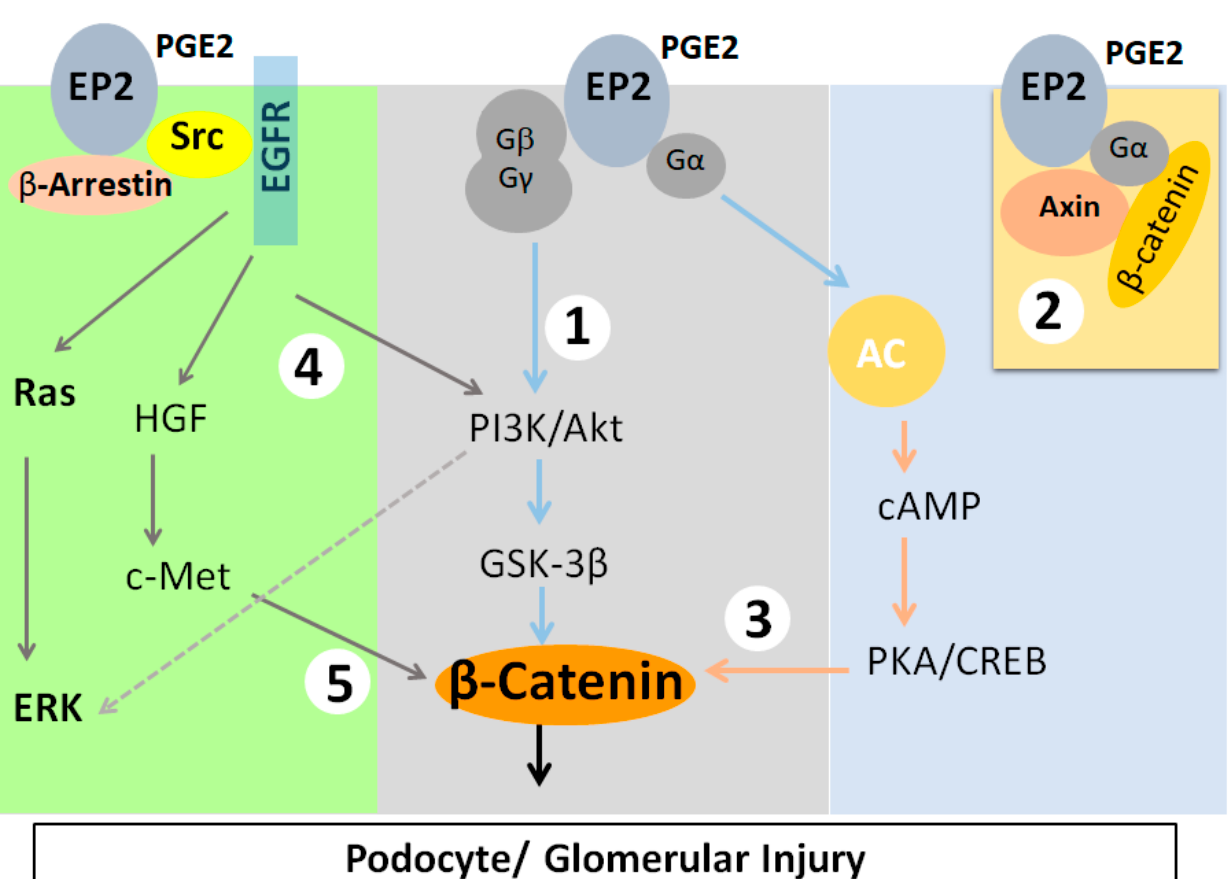
Figure 1. Phosphorylation of β -catenin at Ser552 or Ser675 results in its translocation to the nucleus. EP2 initiates the activation of β -catenin through five known intermediates. As EP2 is a G-protein coupled receptor, it activates the heterotrimeric ( αβγ ) Gs protein, leading to ( 1 ) the release of the G βγ complex, thus activating PI3K/AKT, which phosphorylates and inactivates GSK3 β , resulting in the nuclear translocation of active β -catenin (Middle), ( 2 ) binding of the G α complex to Axin and release of β -catenin from the Axin- β -catenin-GSK3 β complex (Right), and ( 3 ) generation of cAMP and activation of PKA, which activate β -catenin. ( 4 ) The PGE 2 receptor EP2 recruits β -arrestin 1 and phosphorylates Src-kinase, which transactivates the EGFR signaling network of the PI3K/AKT, HGF/c-Met, and Ras/ERK pathways. ( 5 ) The transactivation of c-Met by PGE 2 through EGFR also leads to an increase in nuclear β -catenin (Left). EP2 activation and PI3K/AKT also activate extracellular signal-regulated kinase (ERK).